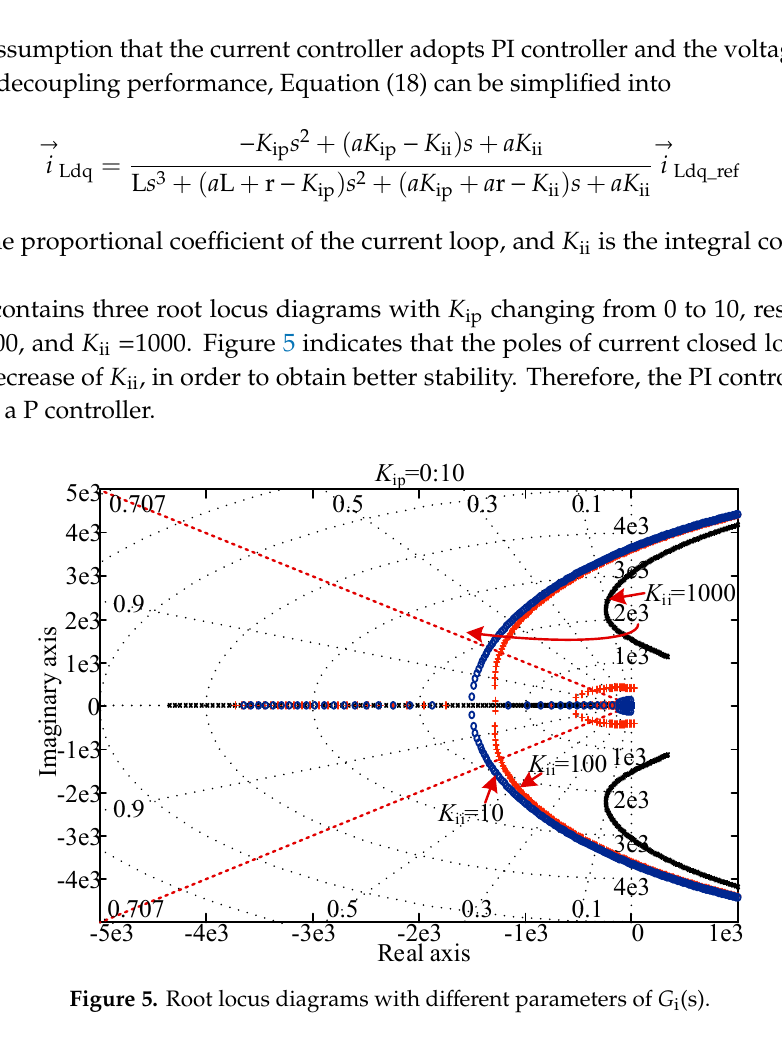
Figure 6. Root locus diagrams with P controller. ( a ) Regardless of coupling; ( b ) Considering coupling.